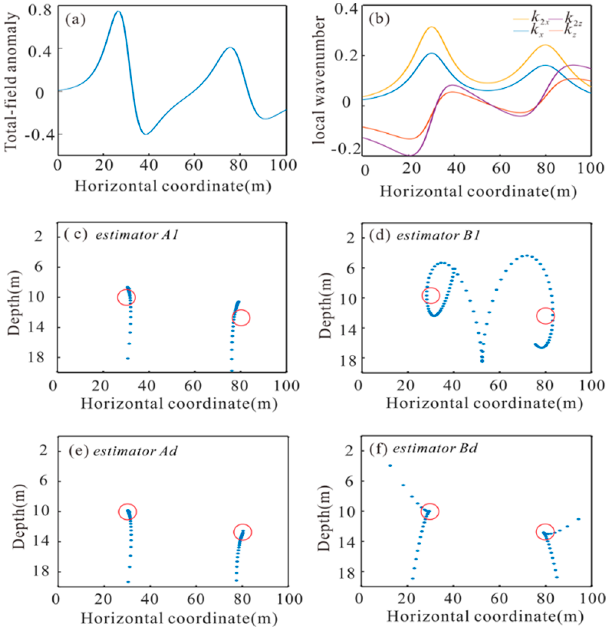
Figure 1. ( a ) Total magnetic anomaly of two cylinders with a magnetic inclination of 60° and a declination perpendicular to strike; ( b ) first- and second-order local wavenumbers of the magnetic anomaly in Figure 1a; ( c ) source location results generated by estimator A1 without screening; ( d ) source location results generated by estimator B1 without screening; ( e ) source location results generated by estimator Ad without screening; ( f ) source location results generated by estimator Bd without screening.